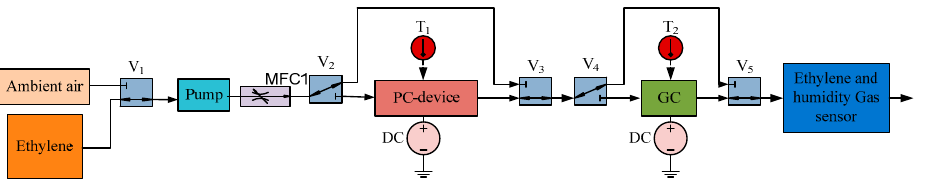
Figure 7. Gas chromatographic system.